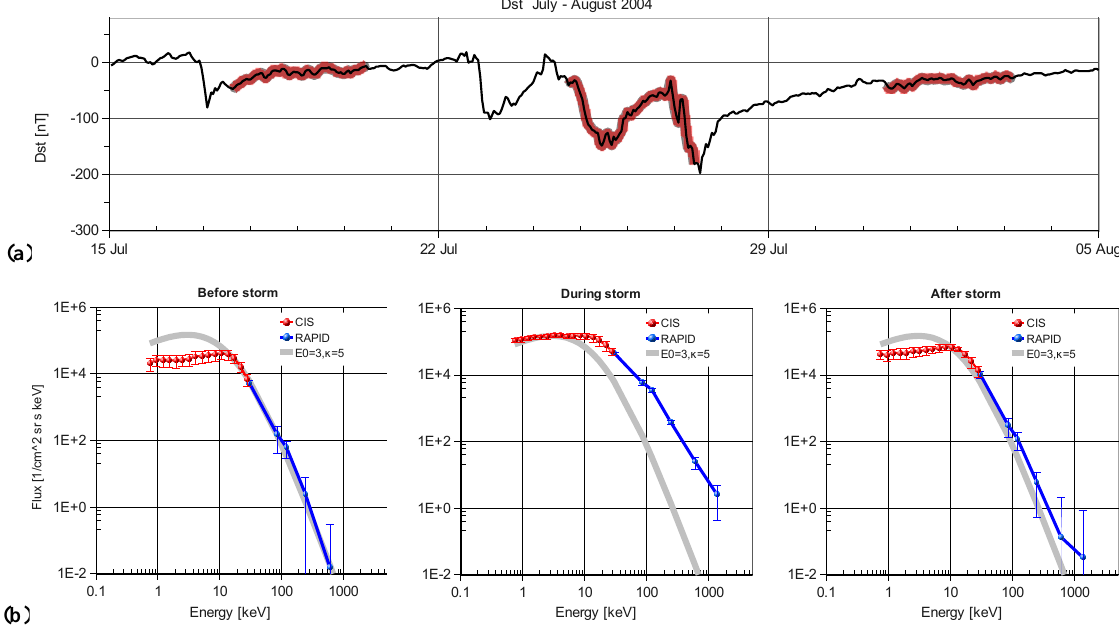
Fig. 3. Ion energy spectra during three phases of two geomagnetic storms. Panel (a) Dst values during 15 July–5 August 2004. Highlighted time intervals indicate periods (Cluster orbit segments during central plasma sheet crossings, though not necessarily continuous measure- ments) used to generate the characteristic spectra in the lower part of the figure. Panel (b) Energy spectra before, during and after the geomagnetic storms on 22–28 July. The dots represent the average proton flux (vertical axes) for each energy channel (horizontal axes) of the RAPID (plotted with blue color) and CIS (red) instrument. Each dot is drawn at the logarithmic center of the respective energy channel (see Table 1), and the error bars indicate the median absolute deviation (MAD – see Eq. 1). To facilitate comparison between the different spectra, we also add a model κ spectrum with κ =5 and E 0 =3keV (gray, solid line) to all spectra in this row.